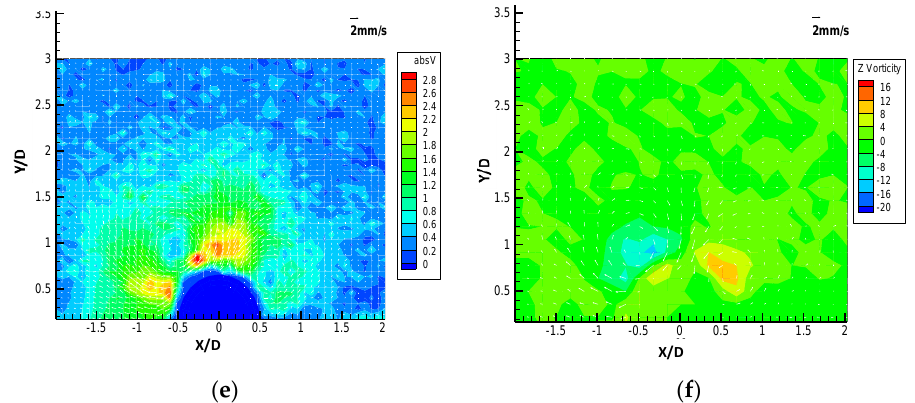
Figure 5. The velocity vector plots with the absolute velocity magnitude ( a , c , e ) and Z vorticity contour maps ( b , d , f ) of the three types of obstructions: Gaseous bubble ( a , b ), Liquid droplet ( c , d ) and solid boundary ( e , f ).